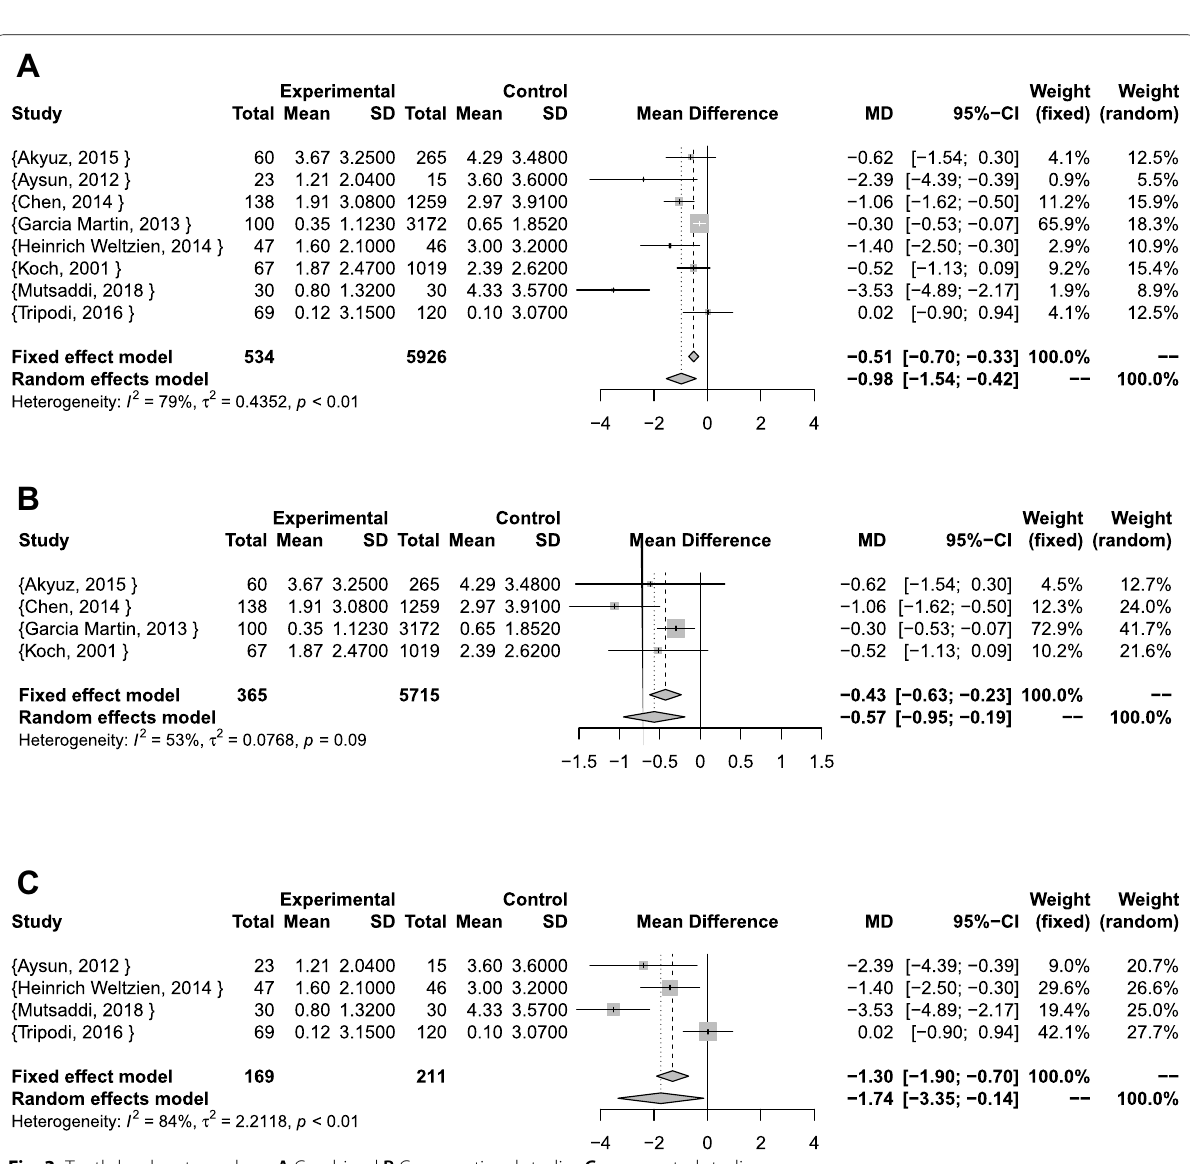
Fig. 3 Tooth-level meta-analyses A Combined B Cross-sectional studies C case-control